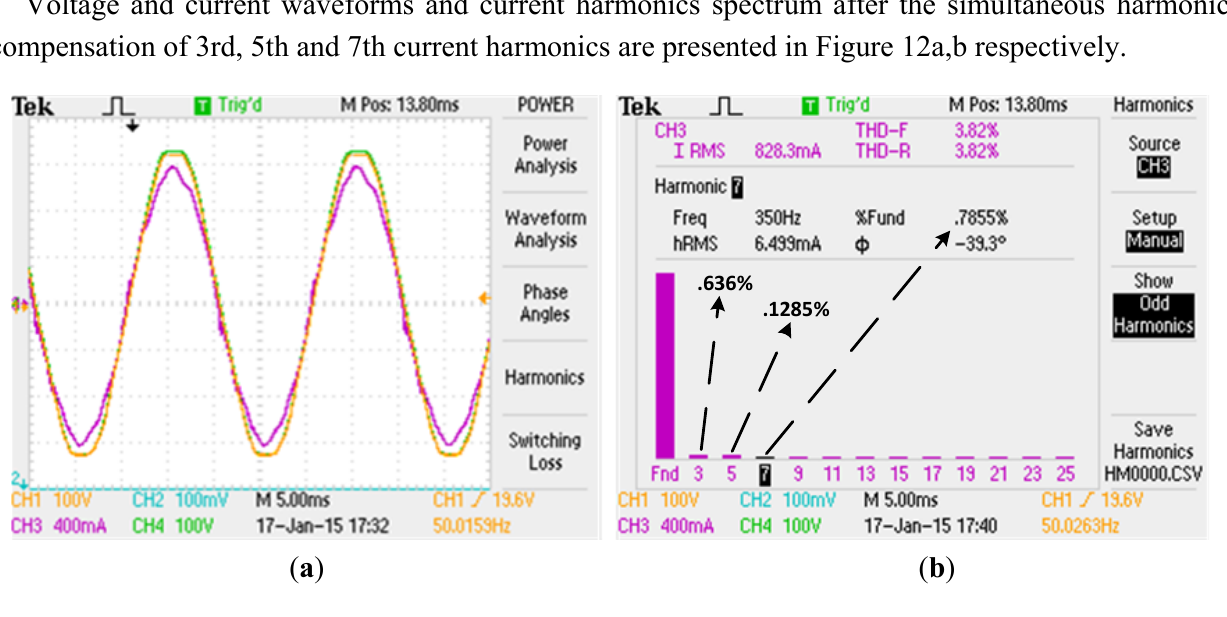
Figure 12. ( a ) Grid’s voltage and current waveforms after compensation of 3rd, 5th and 7th harmonics; ( b ) Grid’s current harmonic spectrum after compensation of 3rd, 5th and 7th